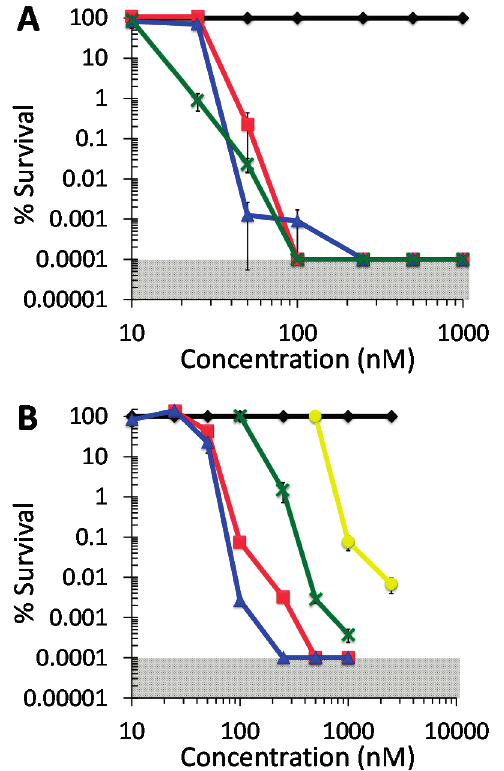
Figure 3. Photodynamic inactivation of bacteria as a function of DIMPy-BODIPY concentration. ( A ) Gram positive species. Displayed is the % survival of the dark control ( ♦ ) and the light treated samples for methicillin-susceptible S. aureus (MSSA) ATCC-2913 ( ■ ), methicillin-resistant S. aureus (MRSA) ATCC-44 ( ▲ ), and the vancomycin-resistant Enterococcus faecium (VRE) ATCC-2320 strain ( x ). ( B ) Gram negative species. Displayed is the % survival of the dark control ( ♦ ) and the light treated samples for A. baumannii ATCC-19606 ( ■ ), multidrug-resistant A. baumannii (MDRAB) ATCC-1605 ( ▲ ), P. aeruginosa ATCC-97 ( x ), and K. pneumoniae ATCC-2146 ( ● ). For all bacteria, the illumination conditions were as follows: 30 min, 400–700 nm, 65 ± 5 mW/cm 2